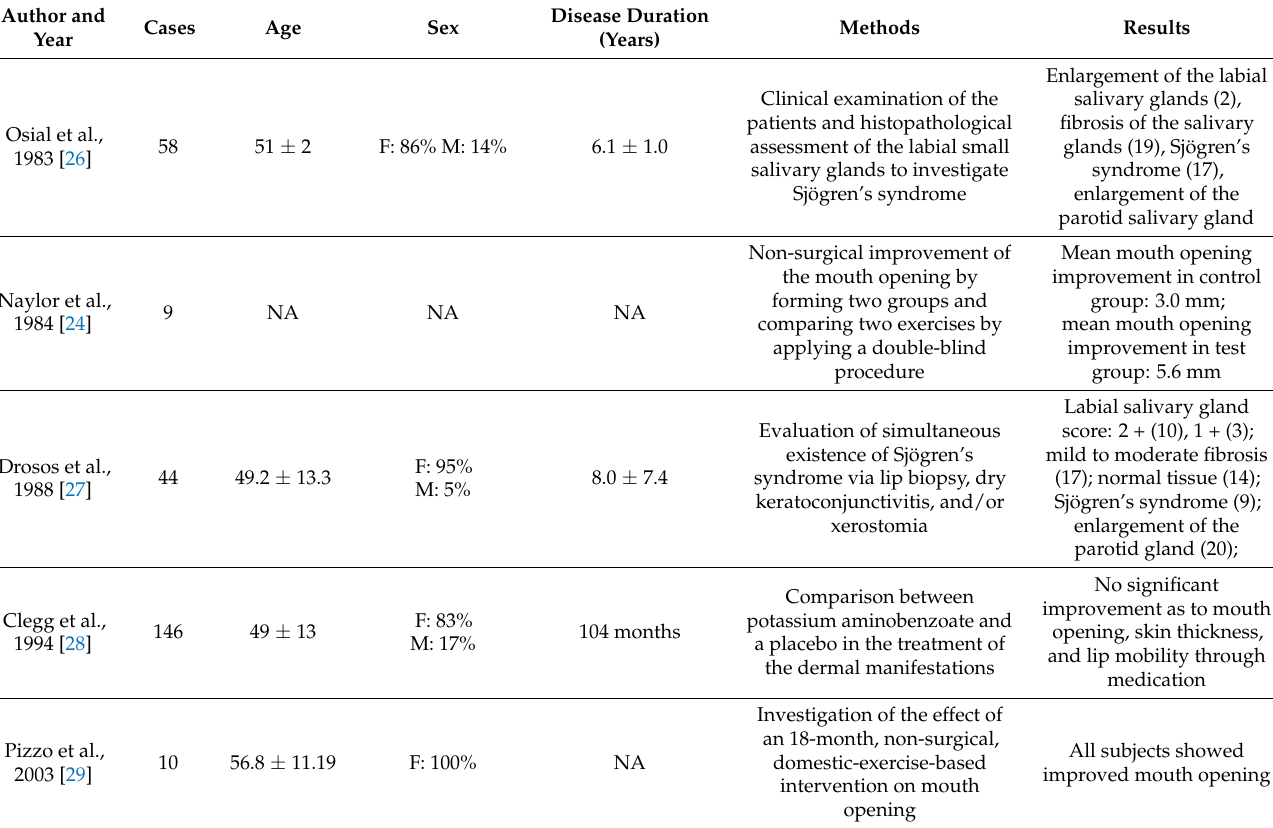
Table 4. Studies included in the